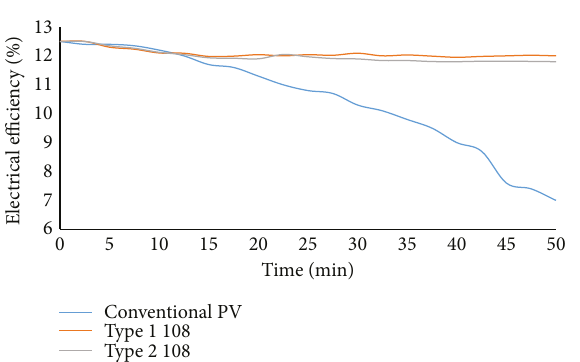
Figure 6: Change of electrical e ffi ciency with 108 pc fi n arrangements at 4.5m/s.